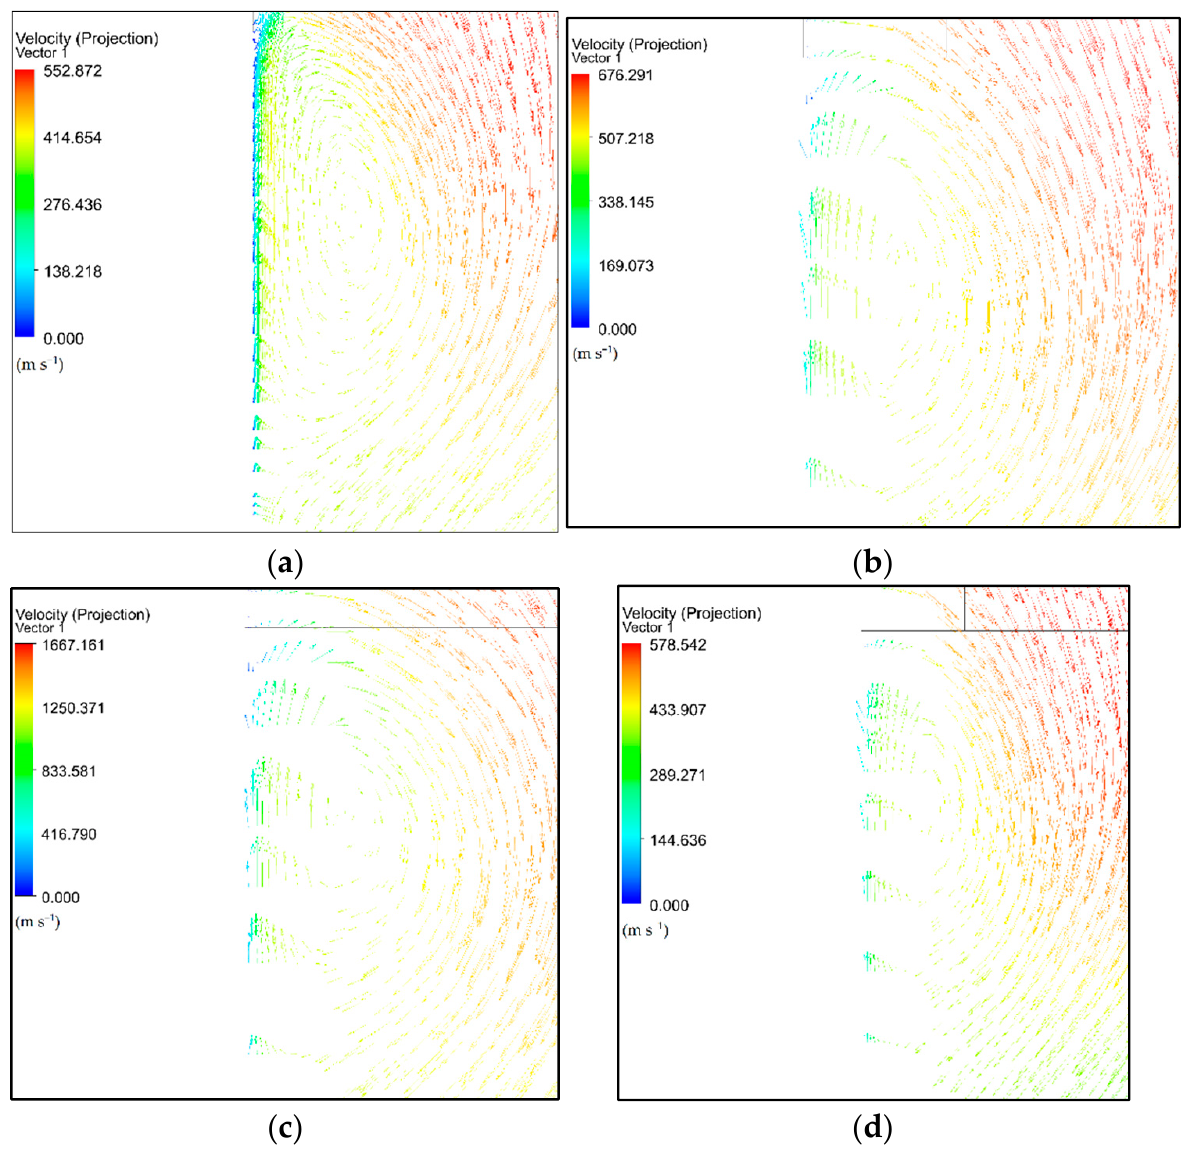
Figure 12. Vector velocity distribution obtained for SVT with ( a ) Ar ; ( b ) air ; ( c ) He ; and ( d ) CO 2 .